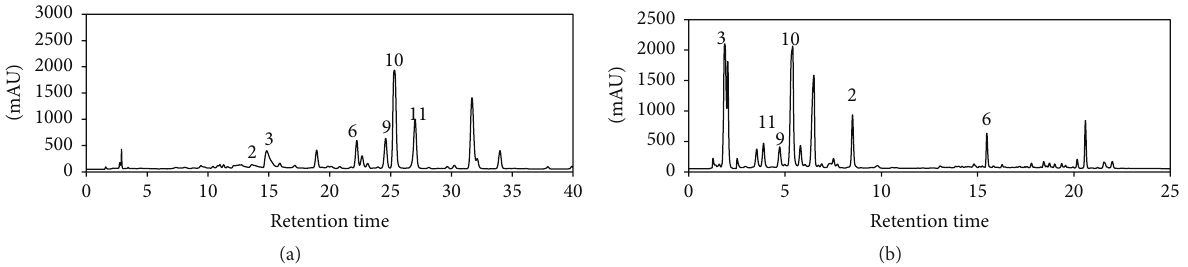
Figure 2: HPLC separation of Corydalis yanhusuo extract using different pH conditions. (a) Basic conditions using xBridge column under